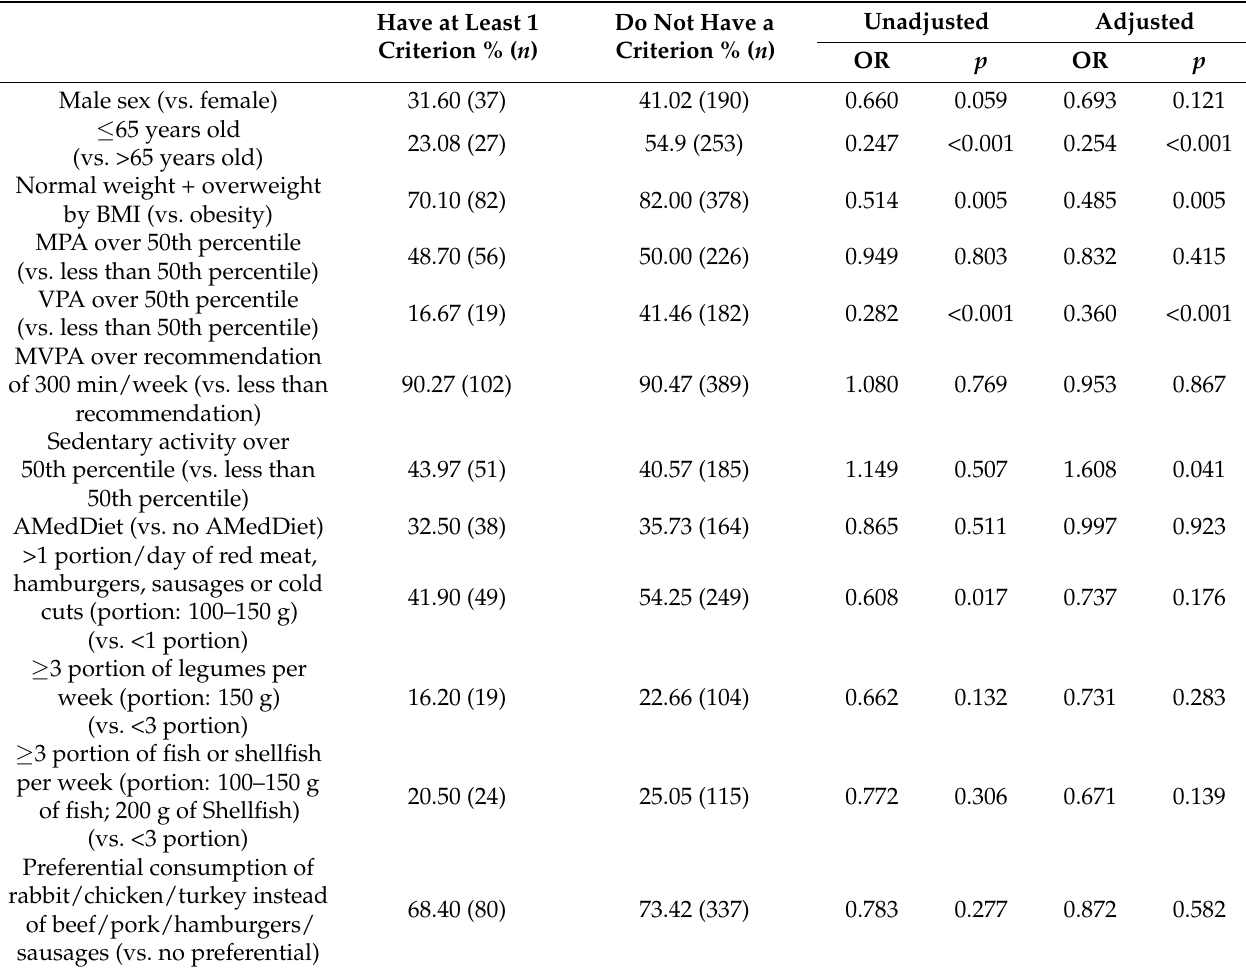
Table 9. Odds ratio of have at least one criterion for sarcopenia by European Consensus unadjusted and adjusted by sex and